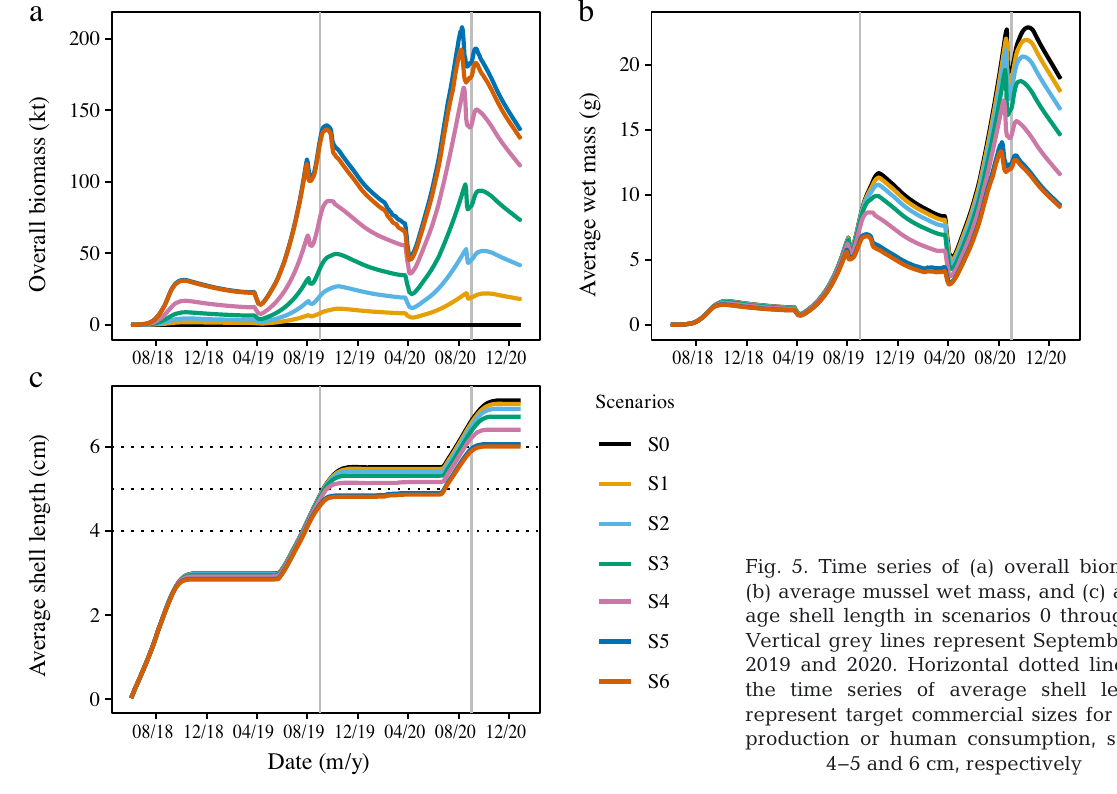
Fig. 5. Time series of (a) overall biomass, (b) average mussel wet mass, and (c) aver- age shell length in scenarios 0 through 6. Vertical grey lines represent September 1, 2019 and 2020. Horizontal dotted lines in the time series of average shell length represent target commercial sizes for feed production or human consumption, set at 4−5 and 6 cm,